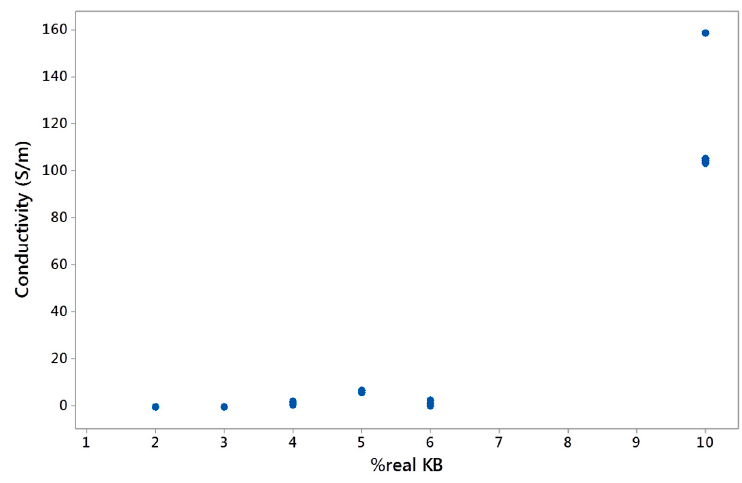
Figure 14. Electrical conductivity (S/m) as a function of the real KB percentage in the biphasic blends.